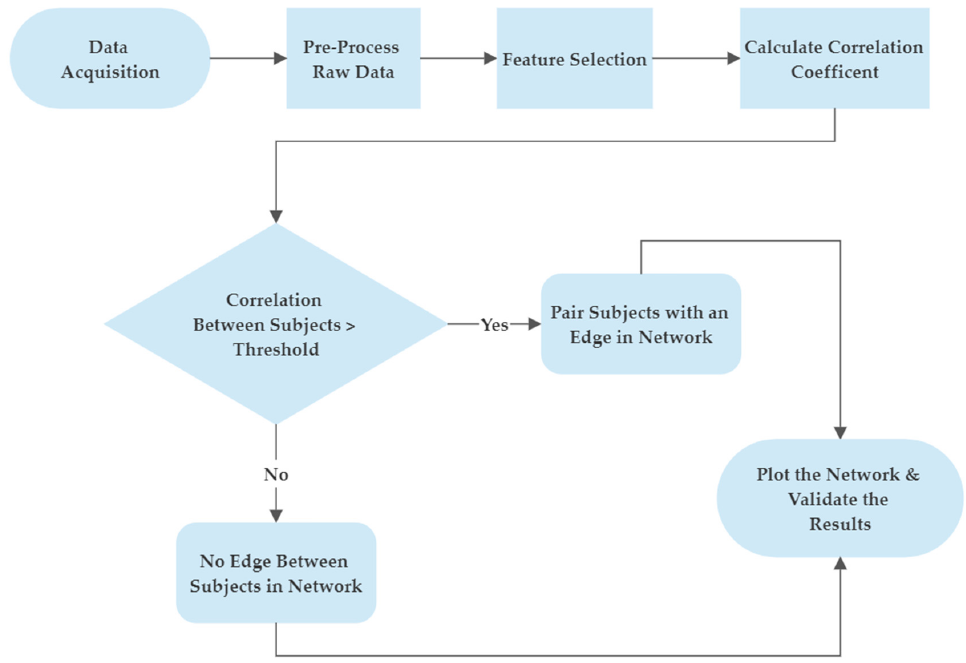
Figure 2. Flow chart of all the steps involved in creating a network model. All the features chosen during the feature selection phase are used to calculate the Pearson pair ‐ wise correlation coefficient for each pair of participants. In this process, we generate a Correlation Matrix (CM) that contains the values of the correlation coefficients between each possible pairs of subjects. Thus, an 18 × 18 CM is produced, where a value at CM [i, j] indicates the Pearson correlation coefficient value between Subjects i and j.